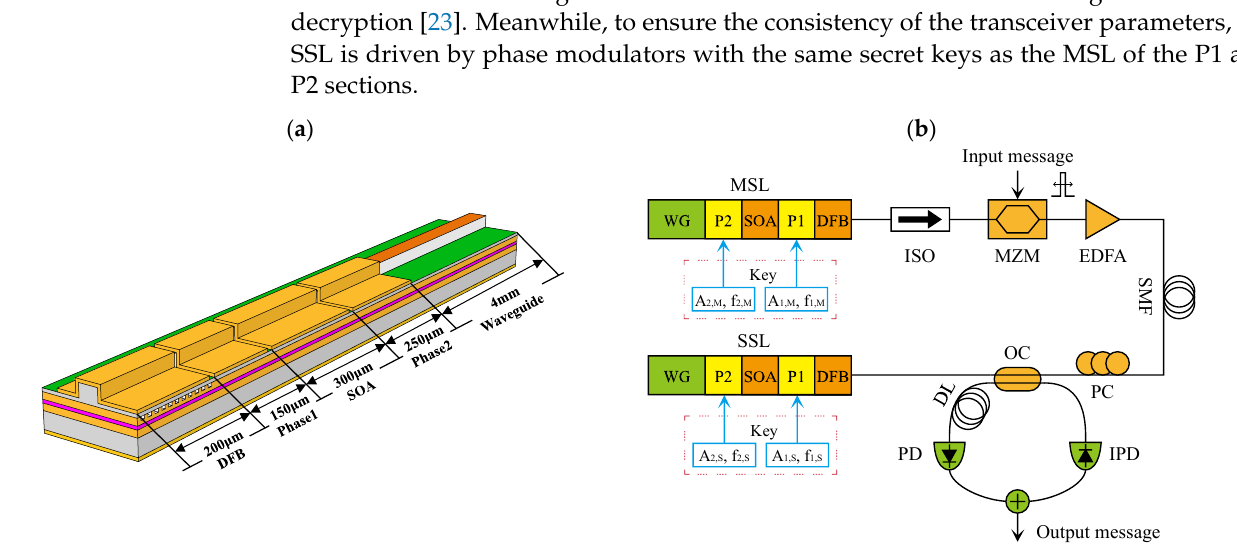
Figure 1. ( a ) The structure of the MIMSL and ( b ) schematic of the chaotic secure communication system. MSL (SSL), master (slave) semiconductor laser; ISO, isolator; MZM, Mach–Zehnder modulator; EDFA, erbium-doped fiber amplifier; SMF, single-mode fiber; PC, polarization controller; OC, optical coupler; DL, optical delay line; PD, photodiode; IPD, inverted photodiode.